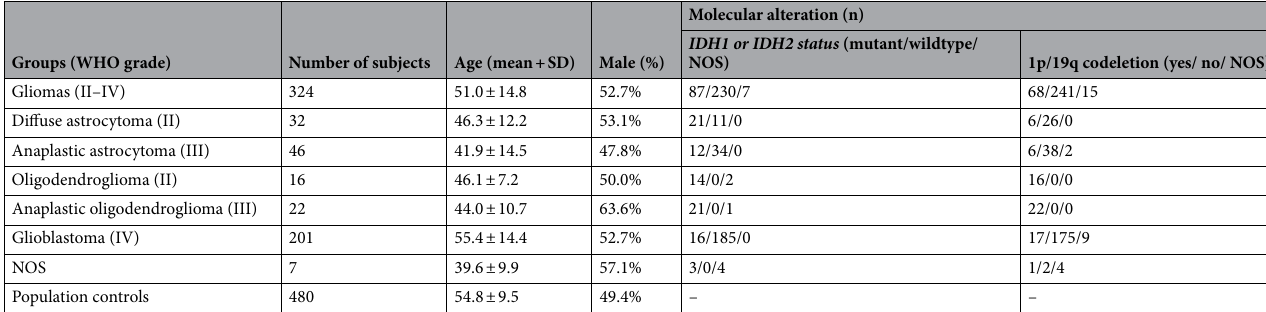
Table 1. Clinical characteristics of study subjects. SD standard deviation, IDH isocitrate dehydrogenase, NOS not otherwise subclassified in